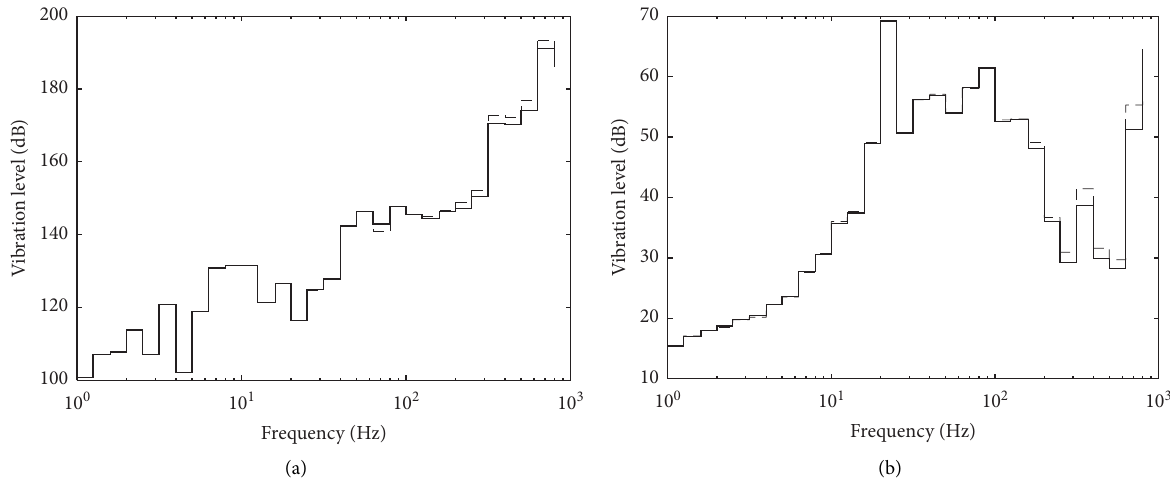
Figure 11: 1/3 Octave band acceleration of the metro track system ( without differential settlement; with differential settlement).